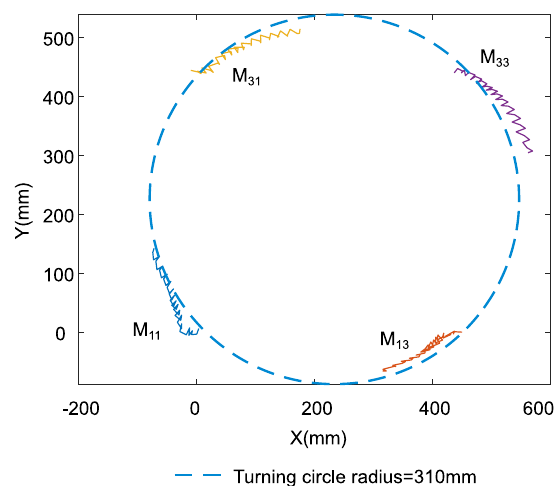
Fig. 19 Trajectory of M 11 , M 13 , M 33 and M 31 of spinning locomotion of WORMESH-II (wave parameters are A = 0.12 π , ω = π/ 20 , and